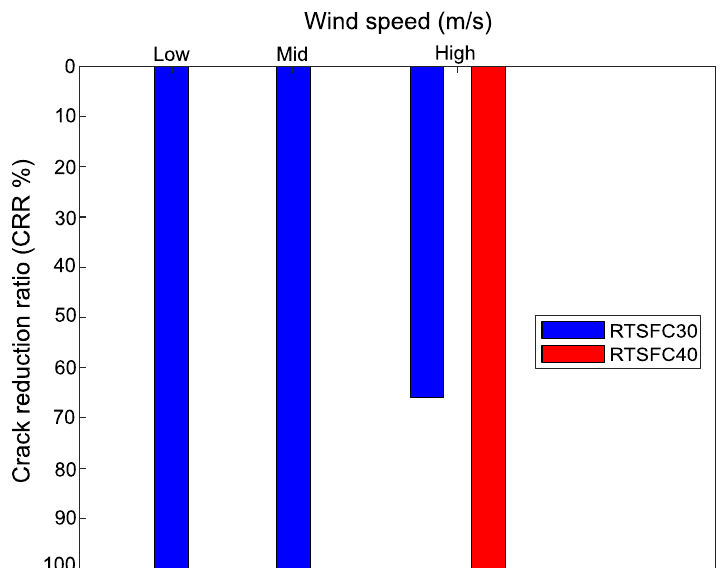
Figure 17. Crack reduction ratio for all wind speeds.